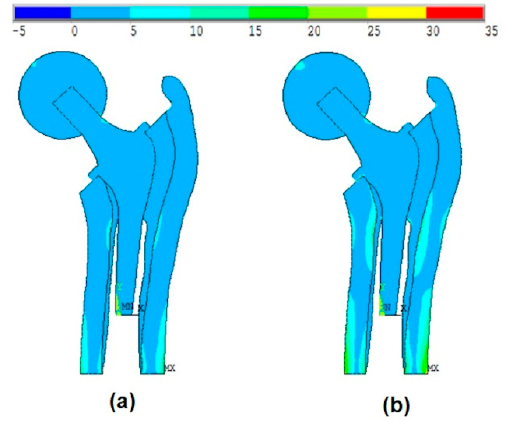
Figure 9. The effect of the introduction of the ball and bone anisotropy on the von-Mises stress distribution at ( a ) the mean point and ( b ) the MPP.